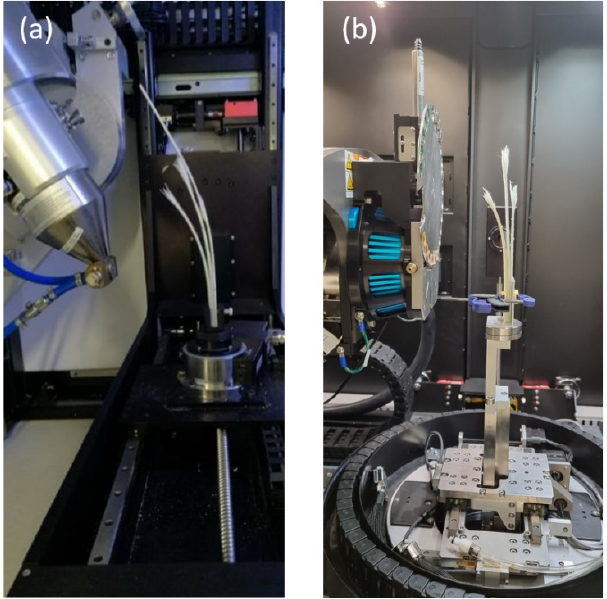
Figure 10. Scanning setup of three samples within the Nikon scanner ( a ) and the Zeiss Xradia 520 Versa scanner ( b ).